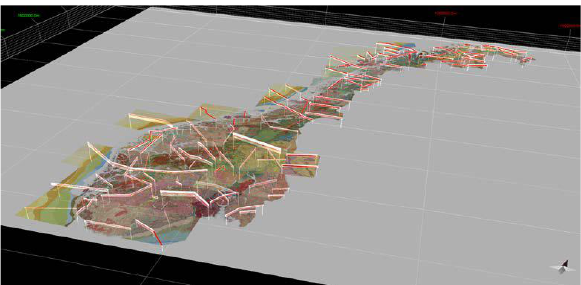
Figure 4: Screen dump from 3DMOVE showing all of the 250K profiles georeferenced in 3D with the bedrock surface geology.